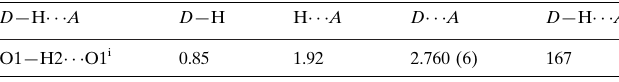
Hydrogen-bond geometry (A˚ , (cid:2)